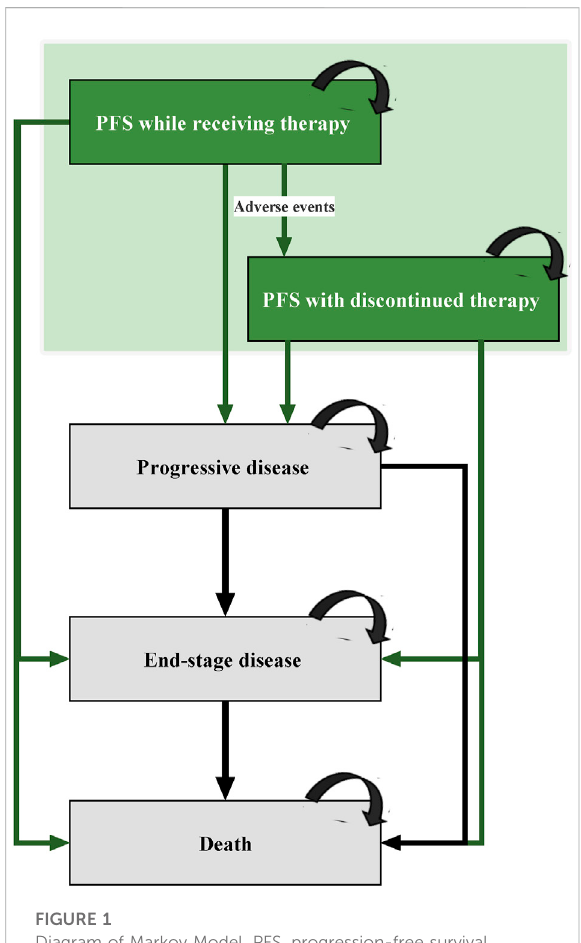
FIGURE 1 Diagram of Markov Model. PFS, progression-free